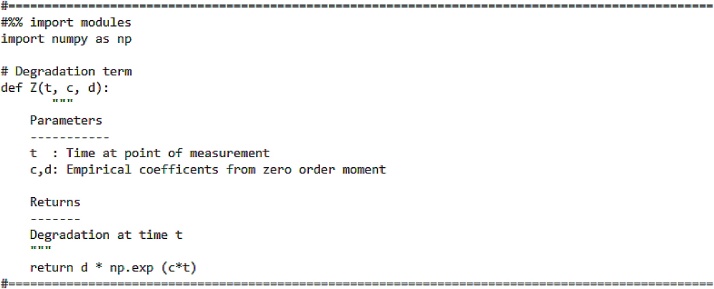
Code for degradation term.